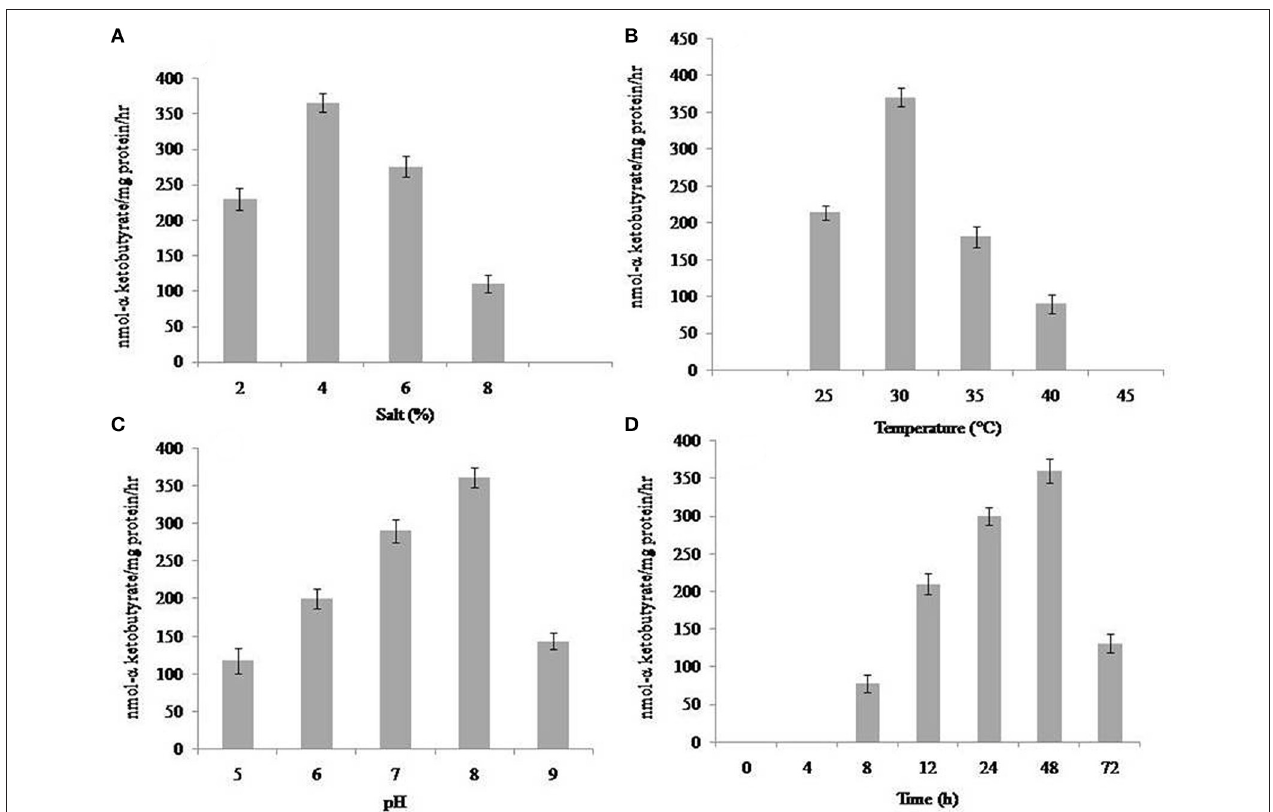
FIGURE 1 | Evaluation of ACC deaminase activity of isolate SBP-9 in various physiological conditions; (A) salt stress (B) different temperatures (C) varying pH (D) incubation time. Data represent mean ± SD of triplicate sets.